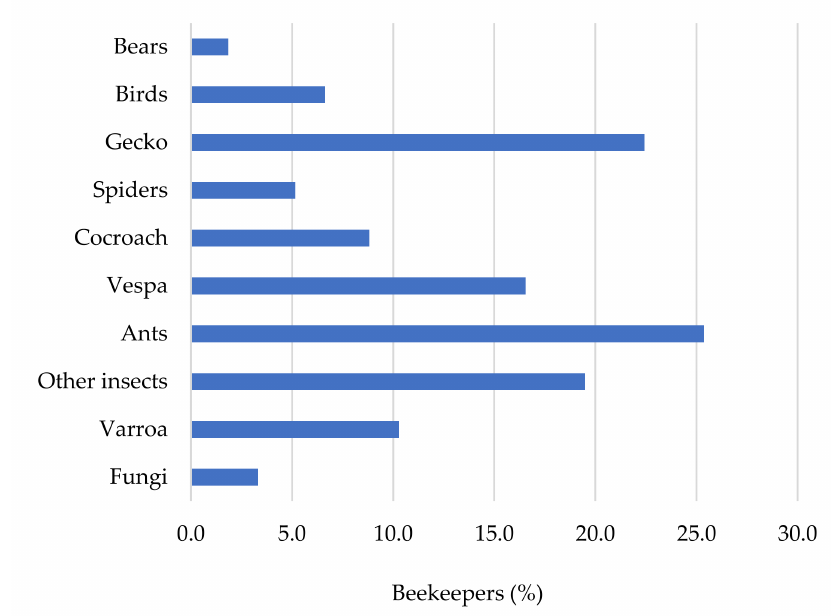
Figure 9. The list of bees predators based on beekeepers’